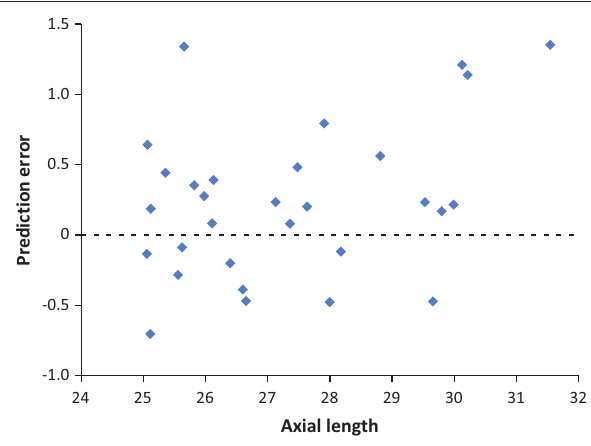
FIGURE 5: Axial length versus prediction error in group